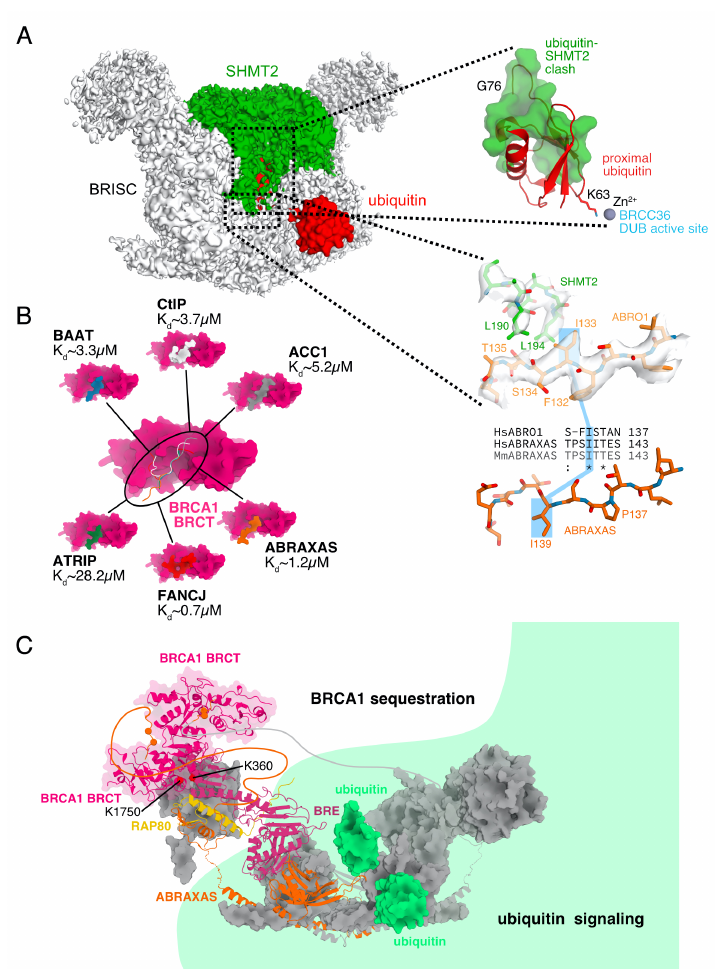
Figure 4. ( A ) Inactivation of BRISC by SHMT2 α binding. A cryo-EM map of BRISC-SHMT2 α complex is shown with a di-ubiquitin fit into the active site using the structure of AMSH-LP with bound di-ubiquitin [80]. The clash between SHMT2 and the proximal ubiquitin is shown in a zoom-out. BRCA1-A complex does not bind SHMT2, because residue I133 of Abro1, which is essential for the interaction, is conserved, but flipped by 180 ◦ due to a proline insertion at position P137. The cryo-EM map of BRISC-SHMT2 α is shown in white while the side chains of SHMT2 and ABRO1 are shown in green and light orange, respectively. The structure of ABRAXAS that corresponds to the part of ABRO1 shown is depicted below in orange (BRCA1-A and BRISC-SHMT2 α structure: [25]). ( B ) ACC1, ATRIP, BAAT, CtIP, and FANCJ compete with the phosphorylated C-terminus of ABRAXAS for the same binding site on BRCA1. Binding affinities measured for the phosphorylated peptide only are in the micromolar range. The entire BRCA1-A complex however binds with nanomolar affinity (ABRAXAS-BRCA1 complex structure: [30], ACC1-BRCA1 complex structure: [83], ATRIP-BRCA1 complex structure: [84], BAAT-BRCA1 complex structure: [84], CtIP-BRCA1 complex structure: [85], FANCJ-BRCA1 complex structure: [86]). ( C ) Crosslinking data suggests that the BRCA1 BRCT domain is localized at the edge of the arc, distal from the active sites of the complex. This model explains why sequestration of BRCA1 by BRCA1-A does not affect the DUB activity of the complex. BRCA1-A can be considered to be divided into a ubiquitin signaling zone (green) and a BRCA1 sequestration zone that are functionally independent (BRCA1-A structure: [25], AMSH-LP-substrate complex structure used for modelling ubiquitin at the active site of BRCA1-A: [80], structure of BRCA1 BRCT dimer with bound ABRAXAS C-terminal phosphorylated peptide: